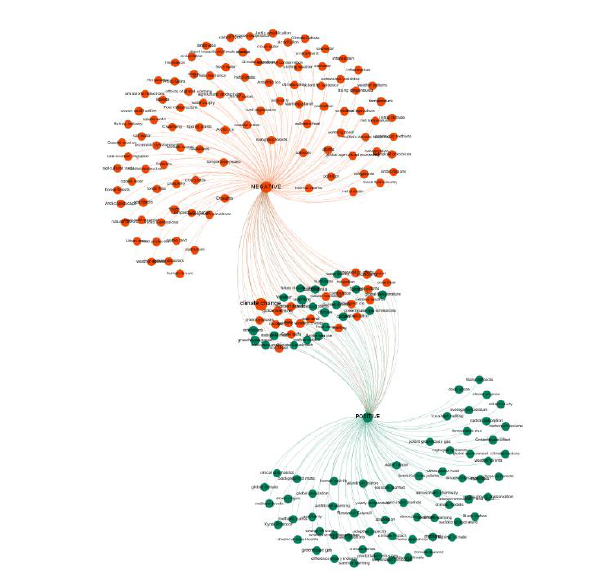
Figure 7 . Locations and emotions network